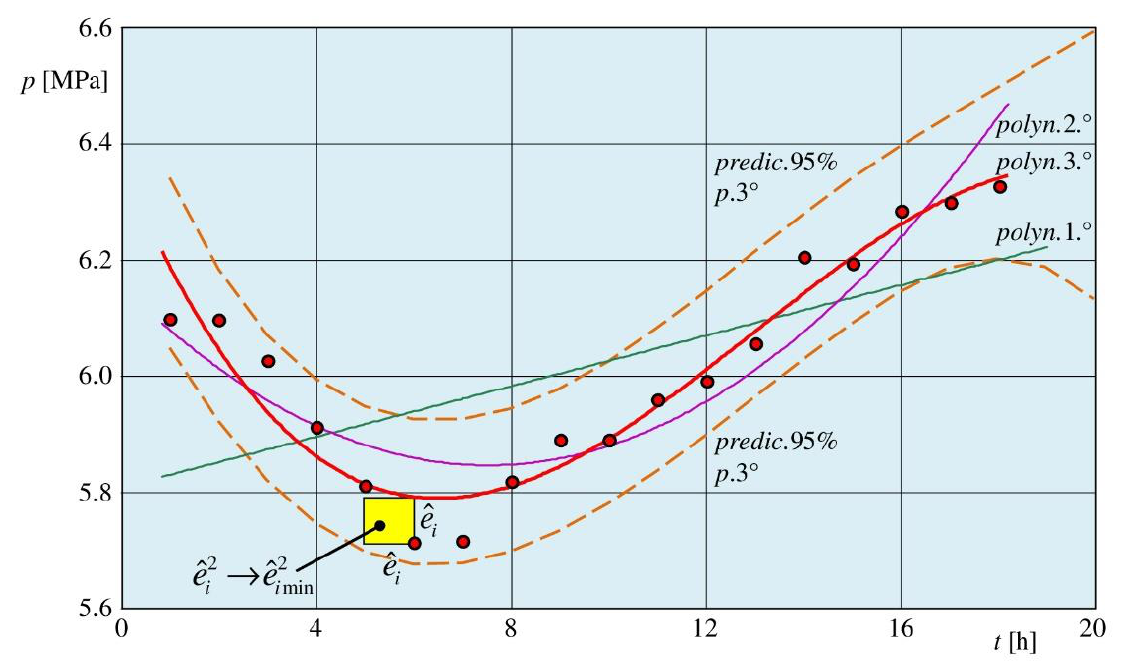
Figure 11. Comparison of three proposed polynomial regression models for the dependence p = f ( t ) and marking of the 95% prediction interval for the applied polynomial model of the third degree.